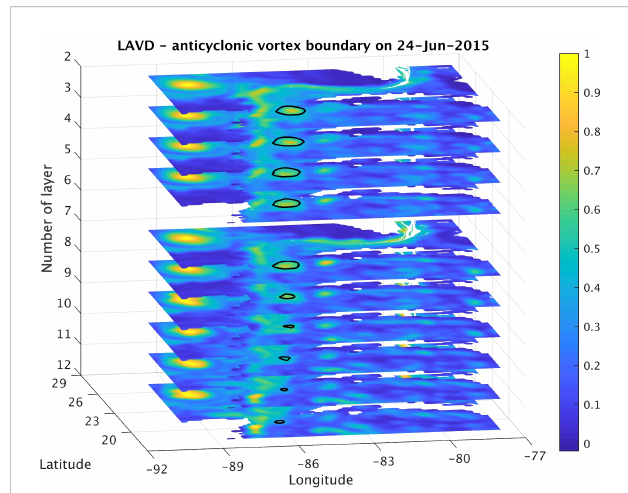
FIGURE 11 Coherent anticyclonic boundary superimposed on the normalized LAVD fi eld in model layers 2 to 12 on June 24, 2015. The normalized LAVD fi eld of layer 6 is not included, because a coherent structure was not detected in this case and particular model layer.